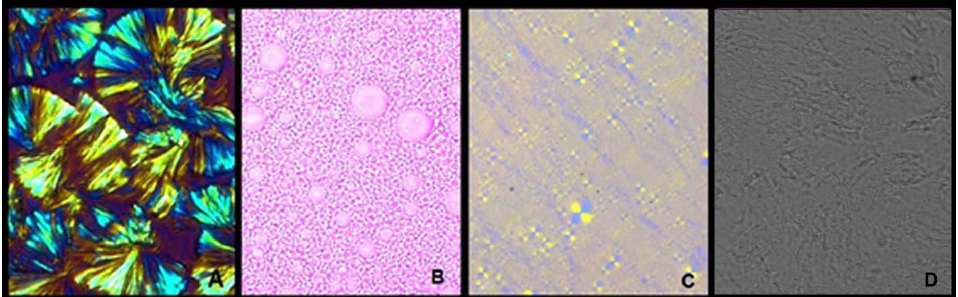
O 2 O (1:1) at 7.5:22.5:35:35 2